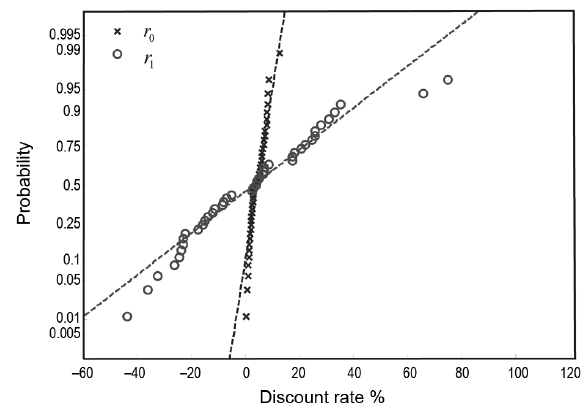
Fig. 5. Normal probability distribution plot test for discount rates regarding energy related items ( r 1 ) and time related